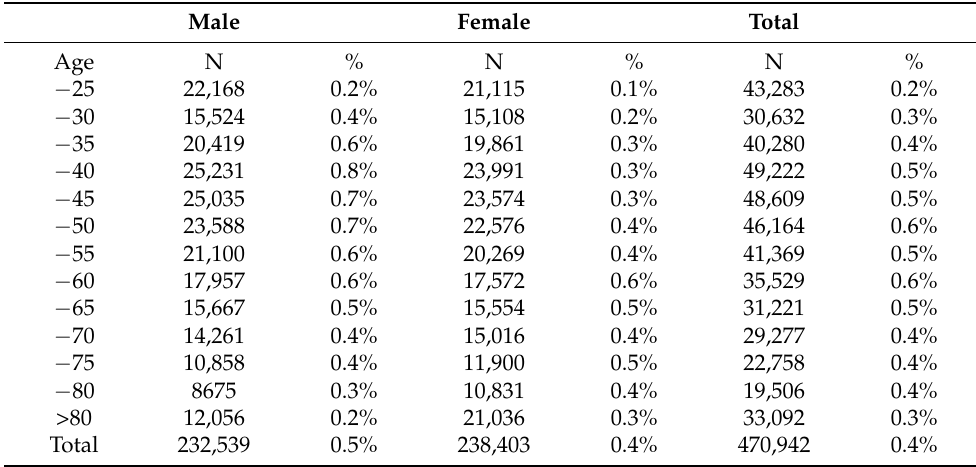
Table 2. Prevalence of Schizophrenia by age and sex.